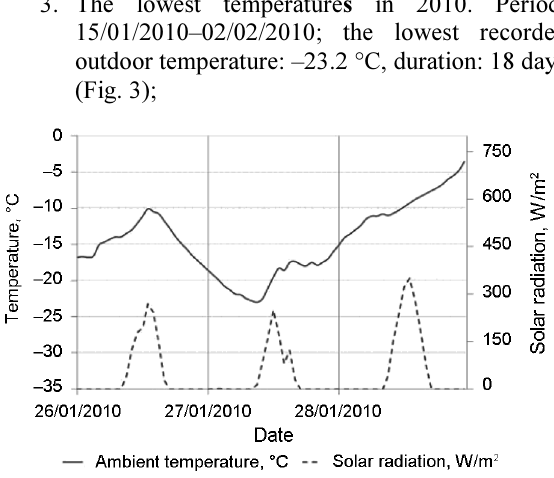
Fig. 3. The lowest temperature s in 2010